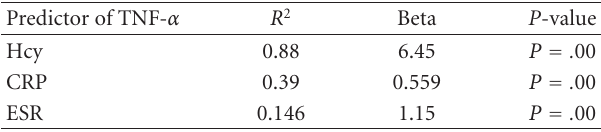
Table 7: Predictors of plasma TNF- α level: regression analysis. Predictor of TNF- α R 2 Beta P -value Hcy 0.88 6.45 P = . 00 CRP 0.39 0.559 P = . 00 ESR 0.146 1.15 P = .